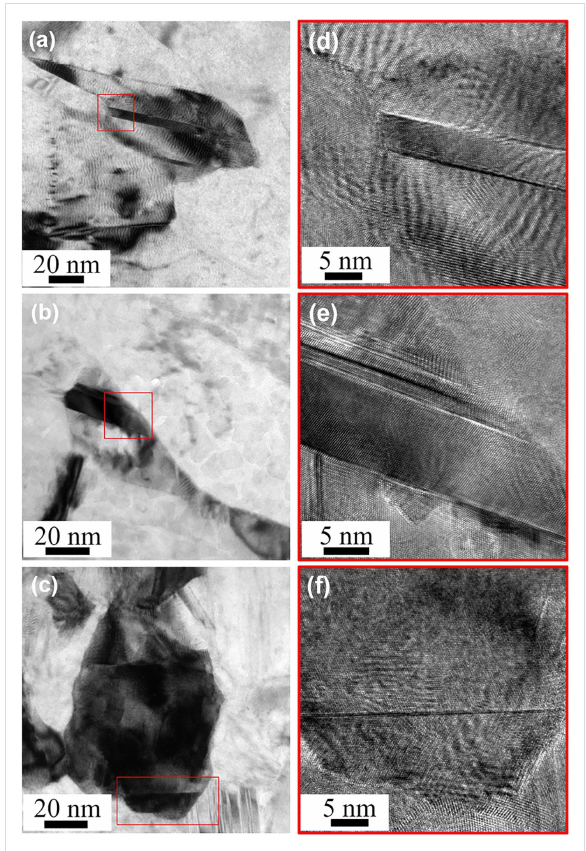
Figure 3: Typical TEM images of the three most common twin mor- phologies highlighted in Figure 2a: (a) twin thickness is around or slightly larger than the TKD step size; (b) twin thickness is much larger than step size; (c) twin thickness is much larger than step size and there is only one coherent twin boundary in the grain interior; (d), (e) and (f) are enlarged features under HRTEM from (a), (b) and (c), re-